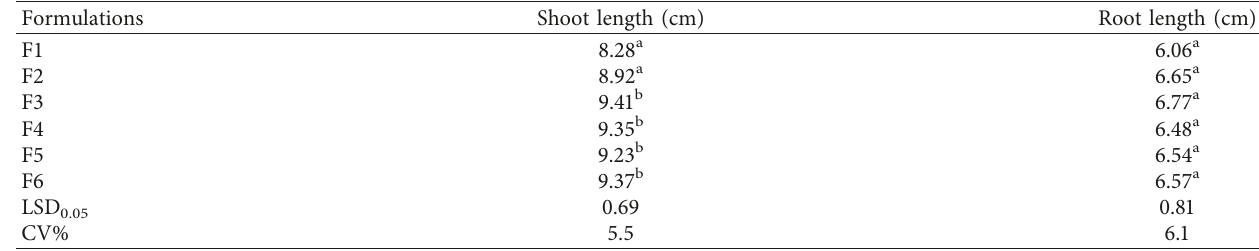
Table 3: Growth indices of soybean seedlings 7days after sowing the coated seeds.